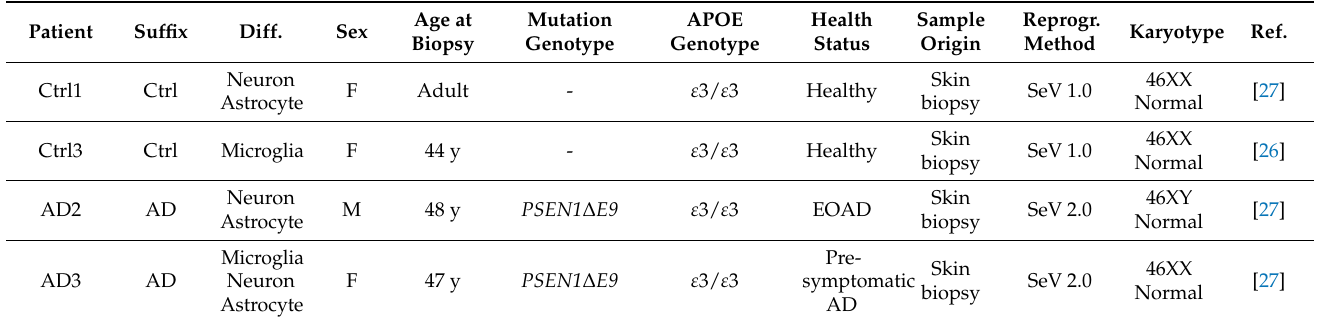
Table 2. Summary of the health controls and Alzheimer’s disease (AD) patients used in the present